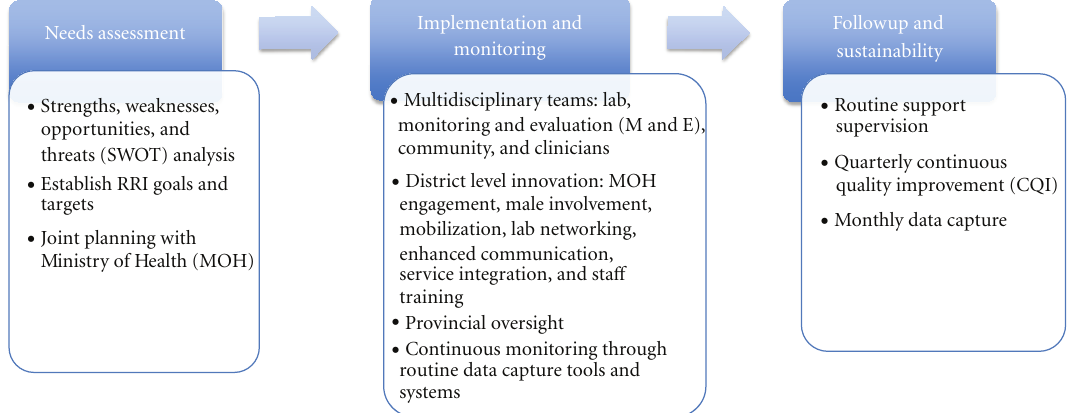
Figure 1: Rapid Results Initiative